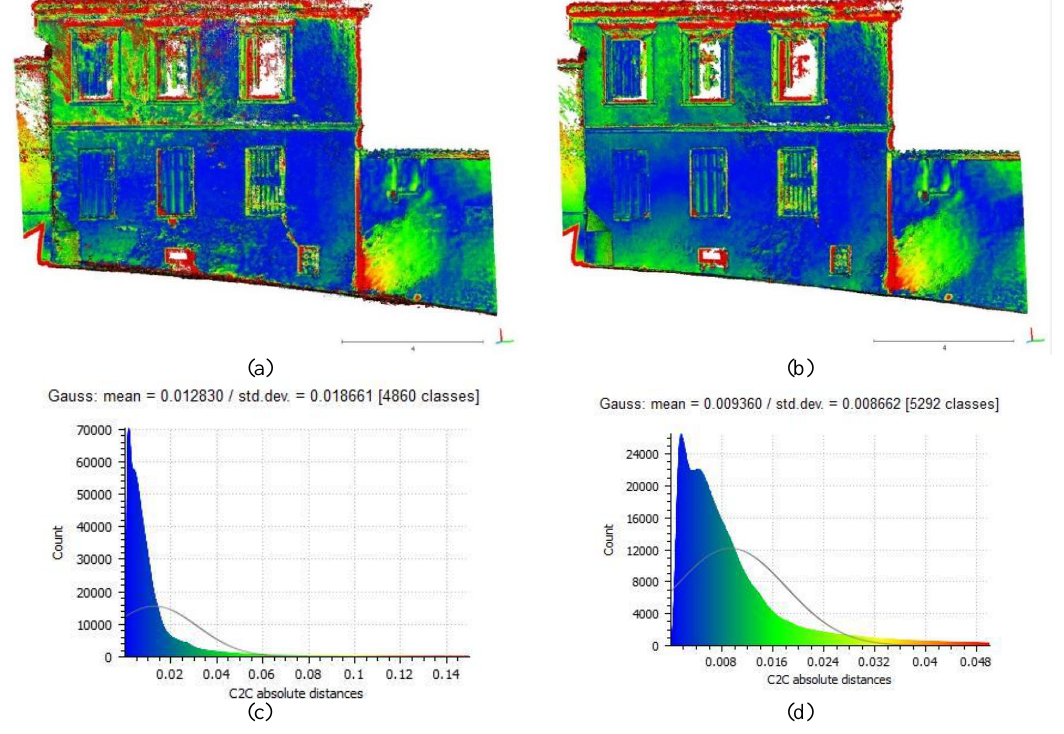
Figure 5: (a) Comparison between dense point clouds from GoPro and 360 o with DSLR camera and respective Gaussian Histogram (c) (b) Comparison between dense point clouds from GoPro with DSLR camera and respective Gaussian Histogram